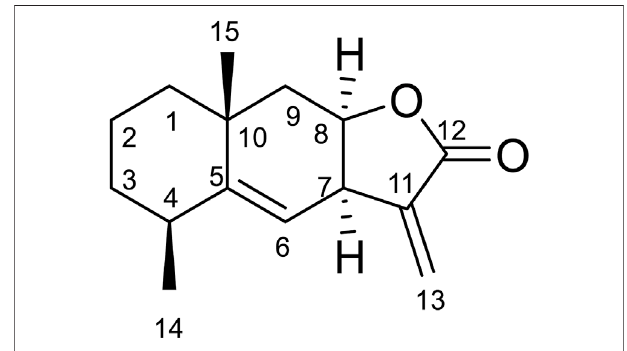
FIGURE 3 | Chemical structural of alantolactone.